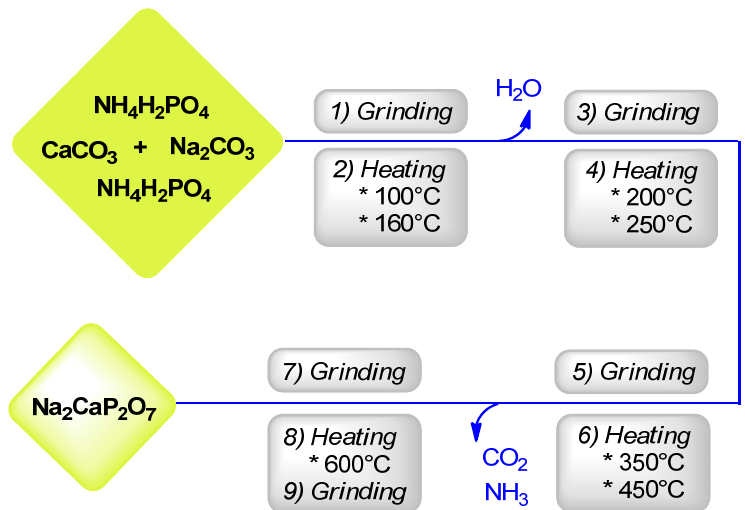
Figure 1. Schematic describing the preparation of Na 2 CaP 2 O 7 nanoparticles.